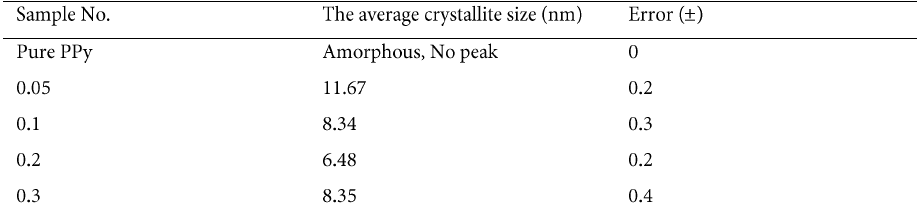
Table 1. Crystallite size was calculated by using Scherrer’s